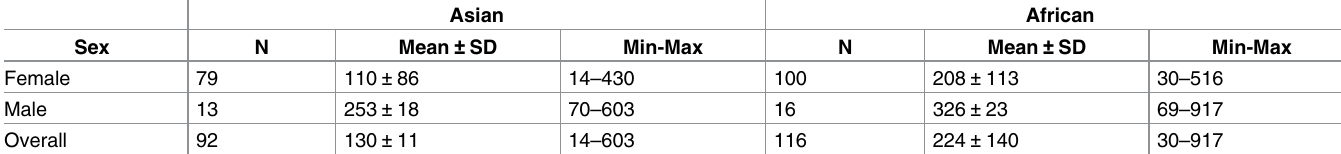
Table 5. Mean ± SD and range (min-max) of the glucose-to-insulin ratio (G:I) in male and female Asian and African